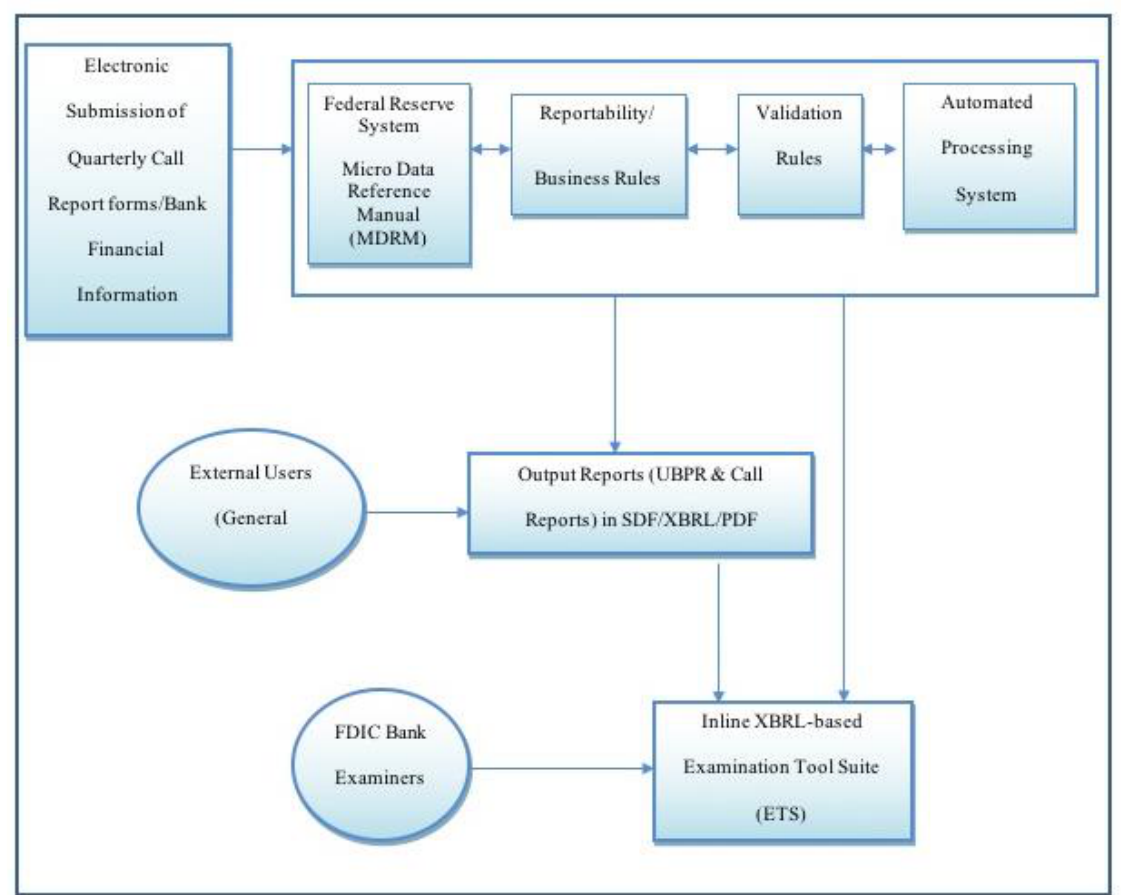
Figure 2. XBRL call report framework.